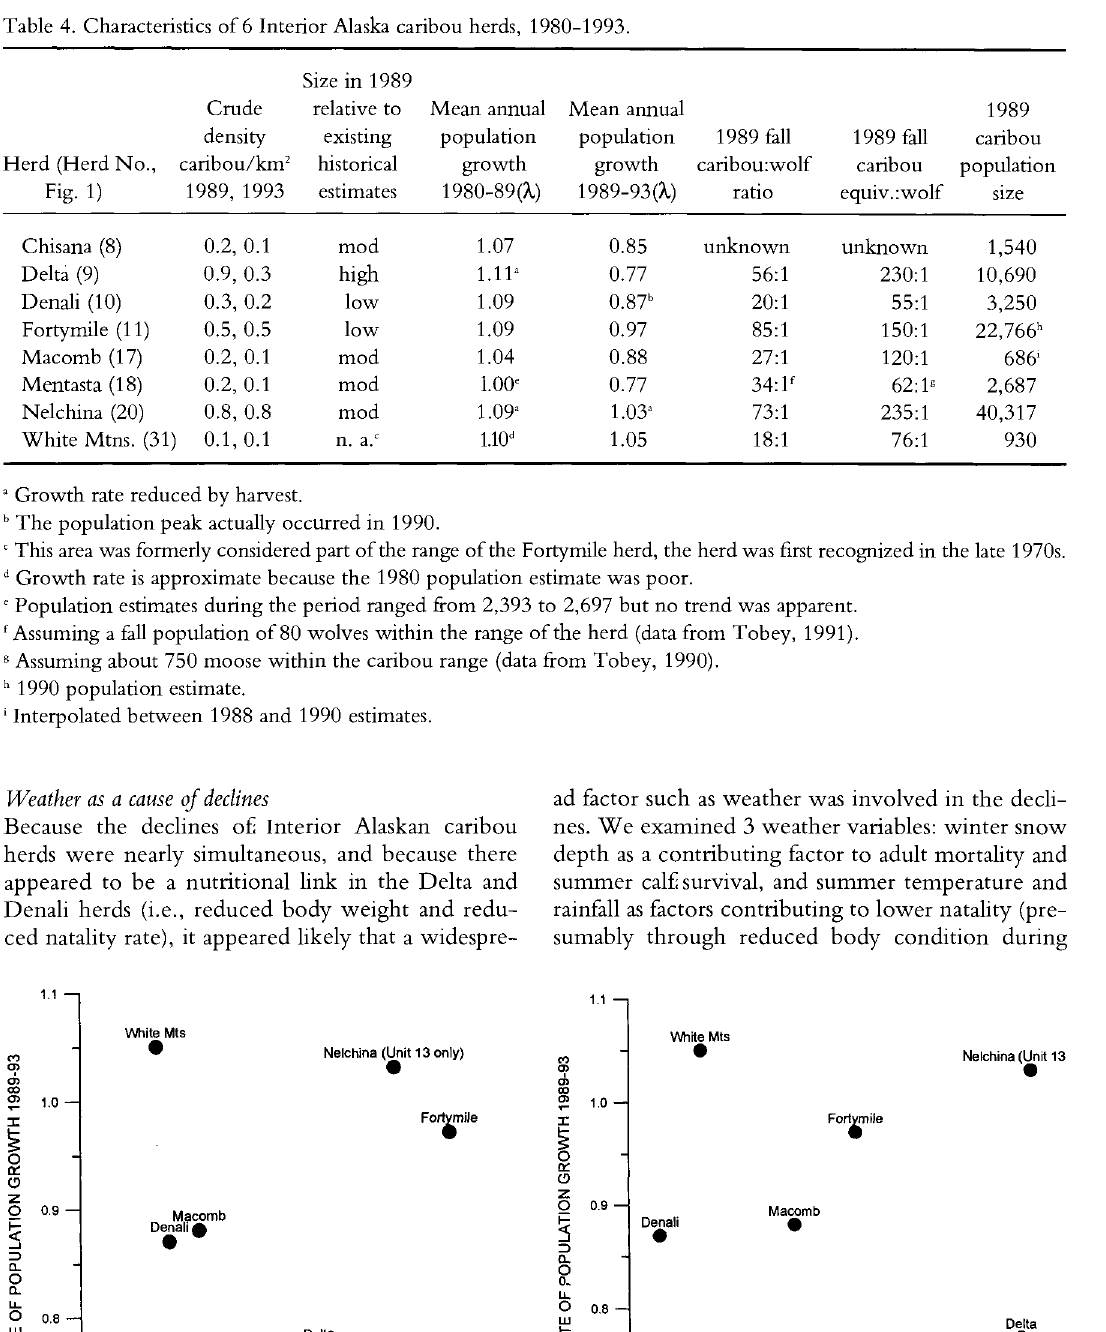
6. Scatter plot of annual average population growth rate (À.) versus caribou equivalents:wolf ratio for 6 Interior Alaska caribou